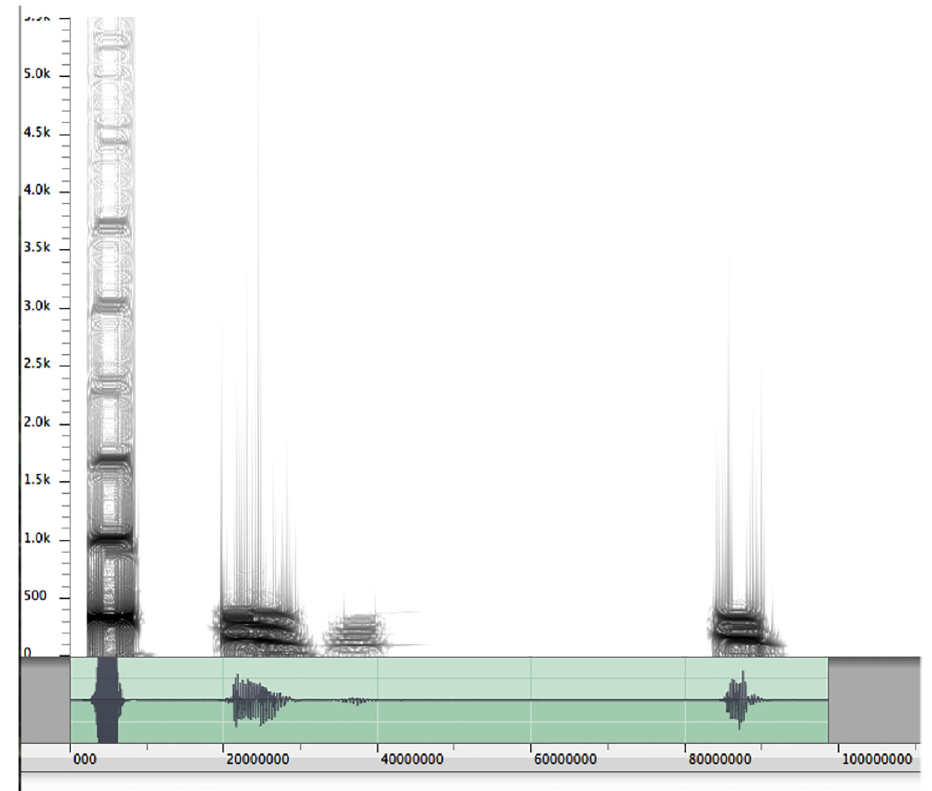
Fig 1. Spectrogram of